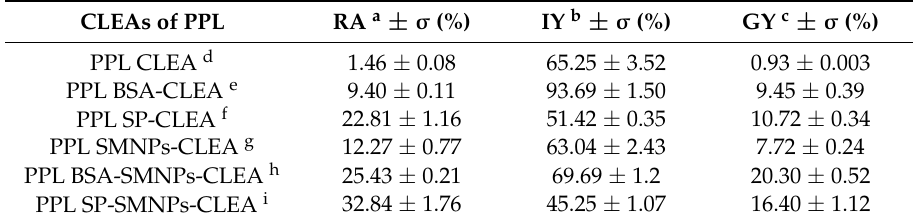
Table 1. Evaluation of the addition of silica magnetic animated nanoparticles (SMNPs) and different protein co-feeders in the preparation of CLEAs of porcine pancreas lipase (PPL). The values are expressed as average of triplicates ± standard deviation ( σ